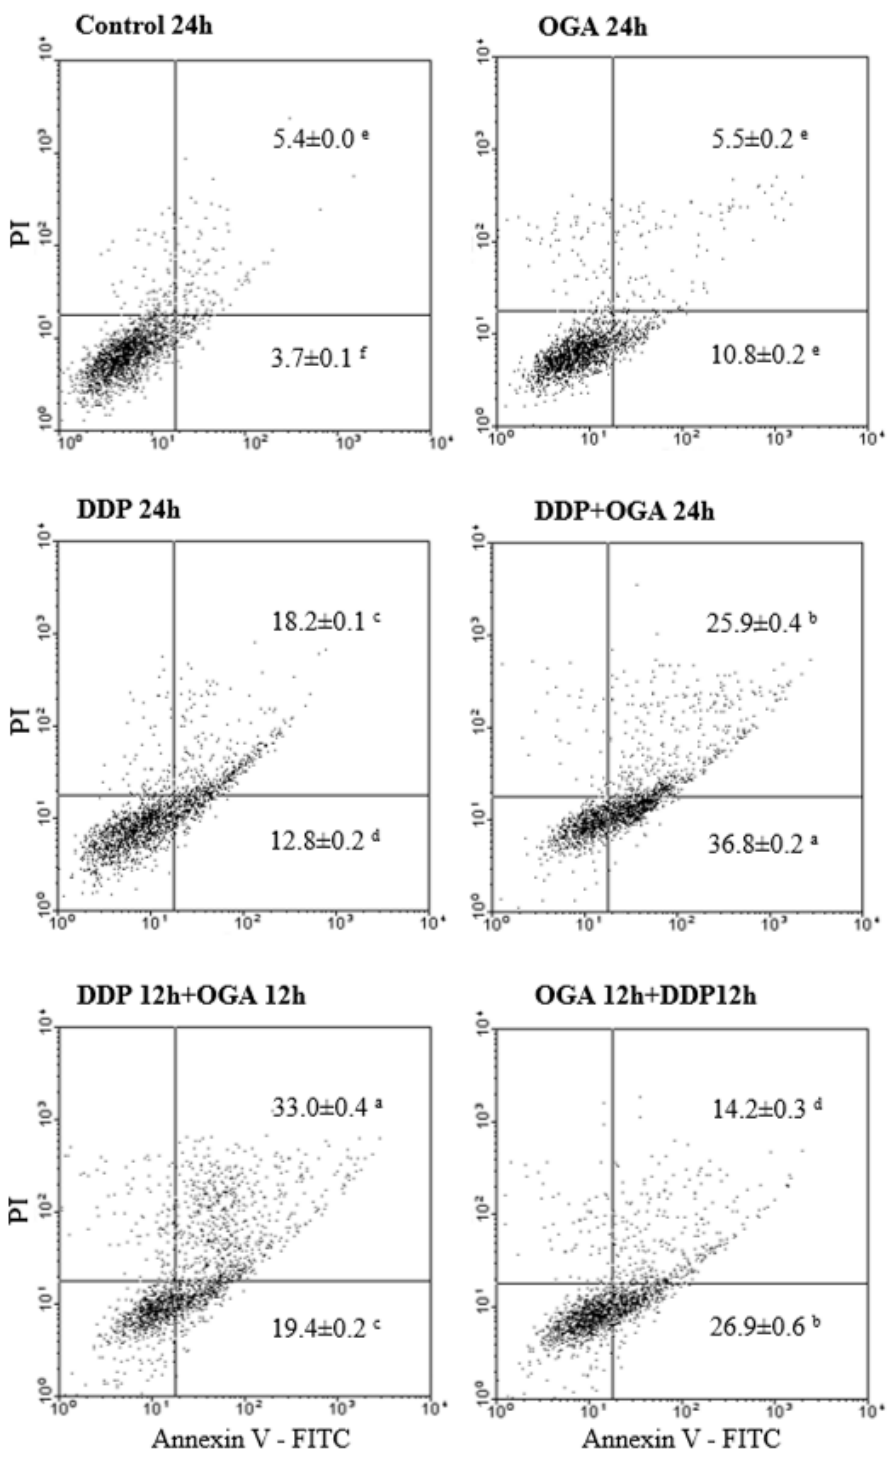
μg/mL, OGA: oligogalacturonides at 100 μg/mL.